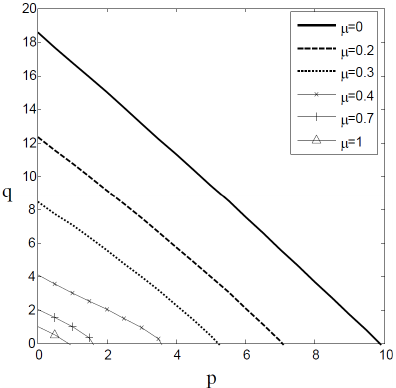
Figure 5. Contour plot of the buckling load q ( p = 0) with respect to µ and k r1 for k r0 = 10 8 (clamped at x = 0) and k t = 10 8 (no translation at x = L ).